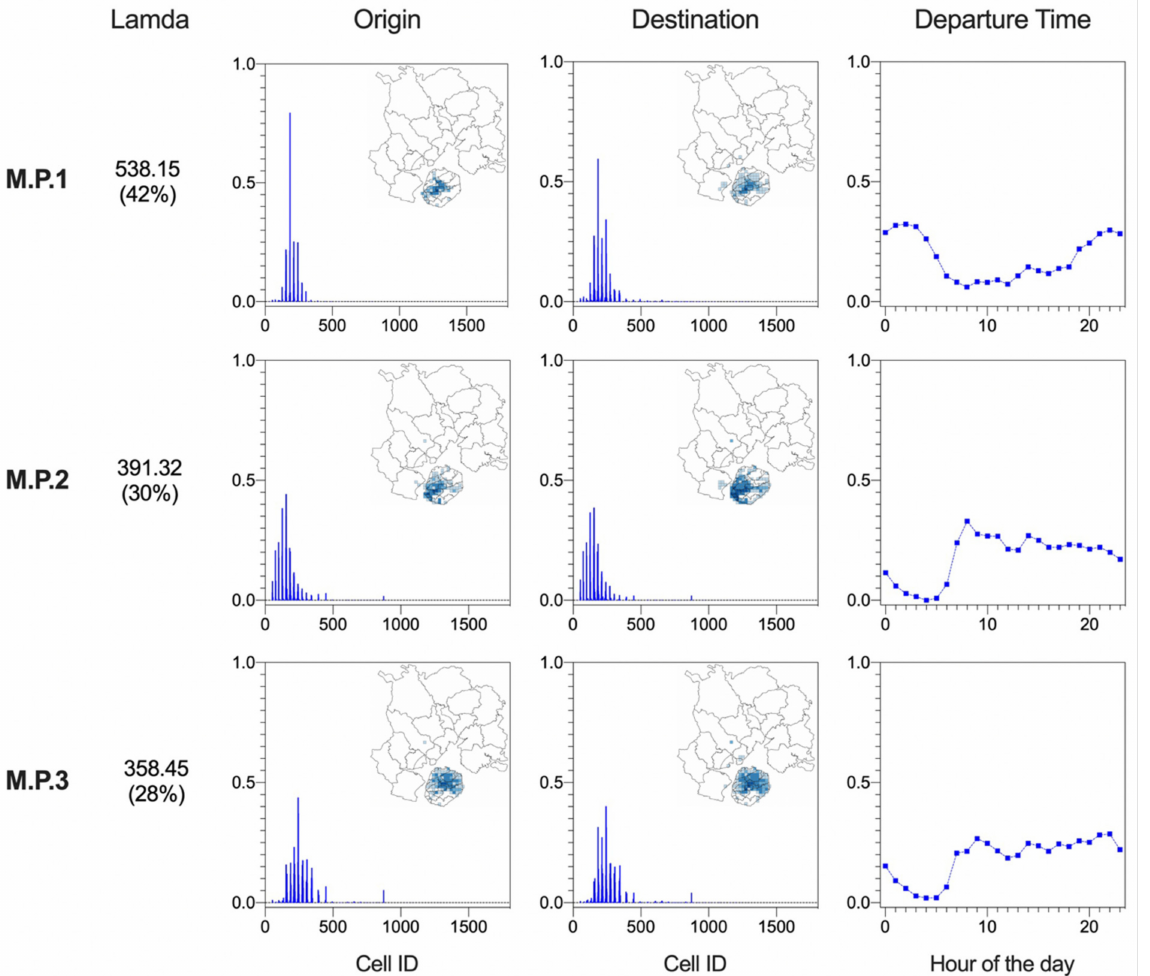
Figure 13. Meta-patterns (M.P.) of taxi mobilities on weekdays. Maps in top right are rendered using graduated colors based on natural